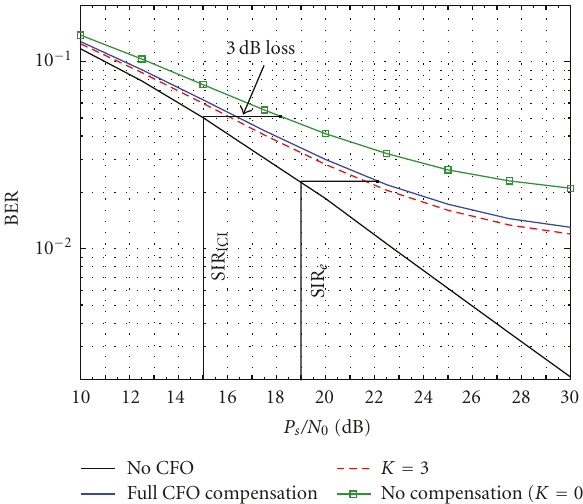
Figure 3: BER performance of SISO system distorted by normalized CFO ω = 0 .